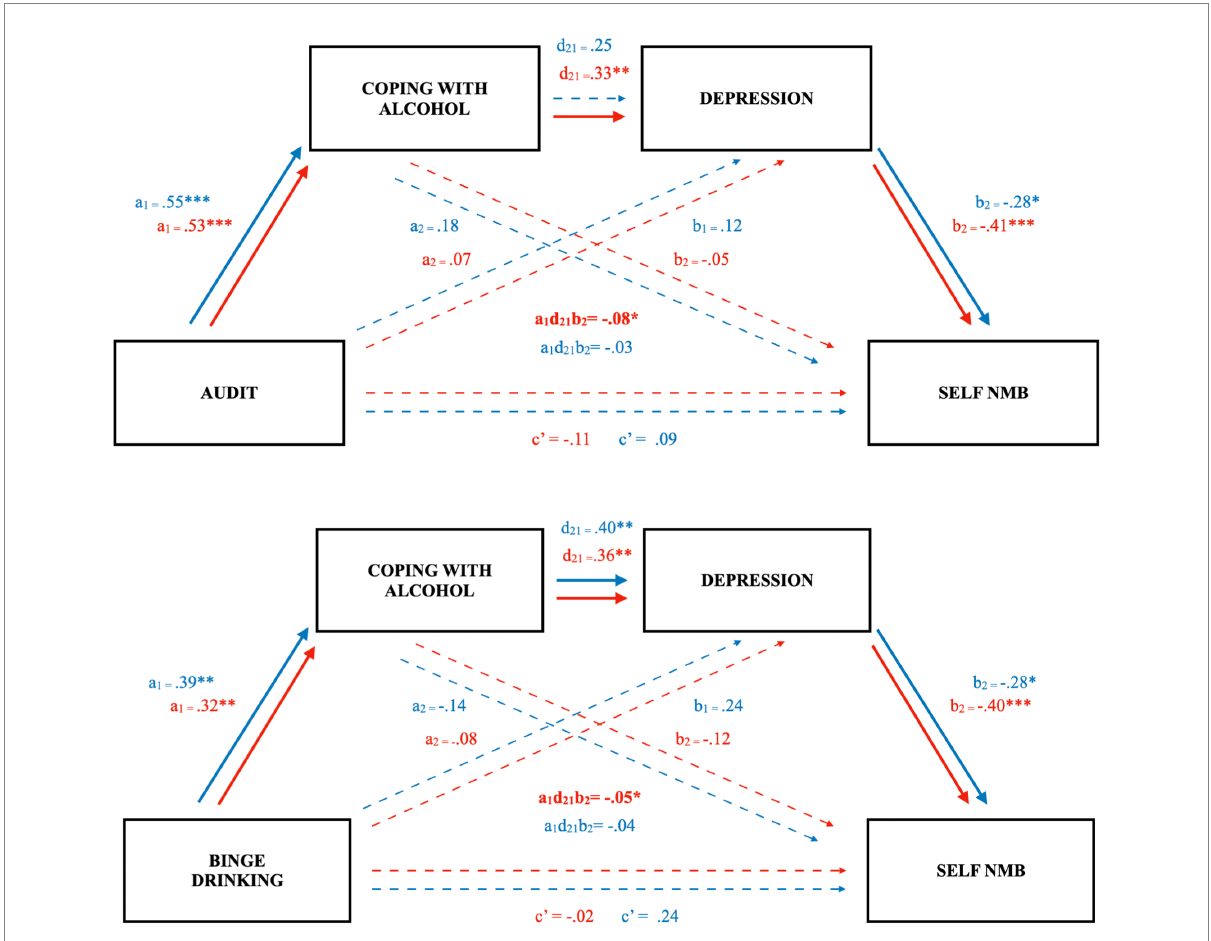
FIGURE 2 Indirect effects of coping motivations and depression on the relation between problematic drinking, binge drinking, and a self-referent memory bias in undergraduate females, but not males (Study 2). Figure depicts separate serial mediation models with females in red, males in blue. Solid lines and bolded parameters reflect significant relations: * p < 0.05, ** p < 0.01, *** p <